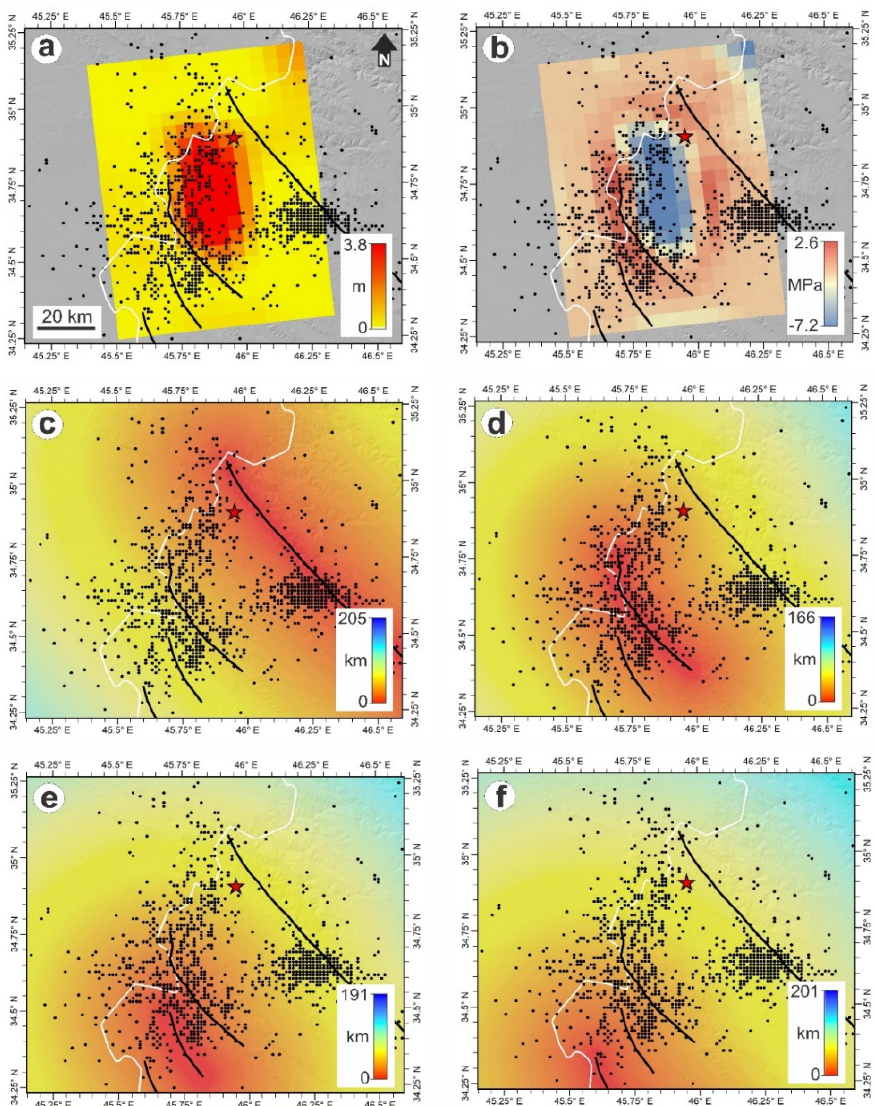
Figure 2. ( a ) Slip distribution map of the M 7.3 event deduced from joint inversion analysis of the Sentinel-1 and ALOS-2 data. ( b ) Coulomb stress change map of the M 7.3 event deduced from the subsampled phase unwrapped displacement results of the Sentinel-1 and ALOS-2 datasets in an elastic half-space [17]. ( c )–( f ) Euclidean distance maps of the neighboring faults.